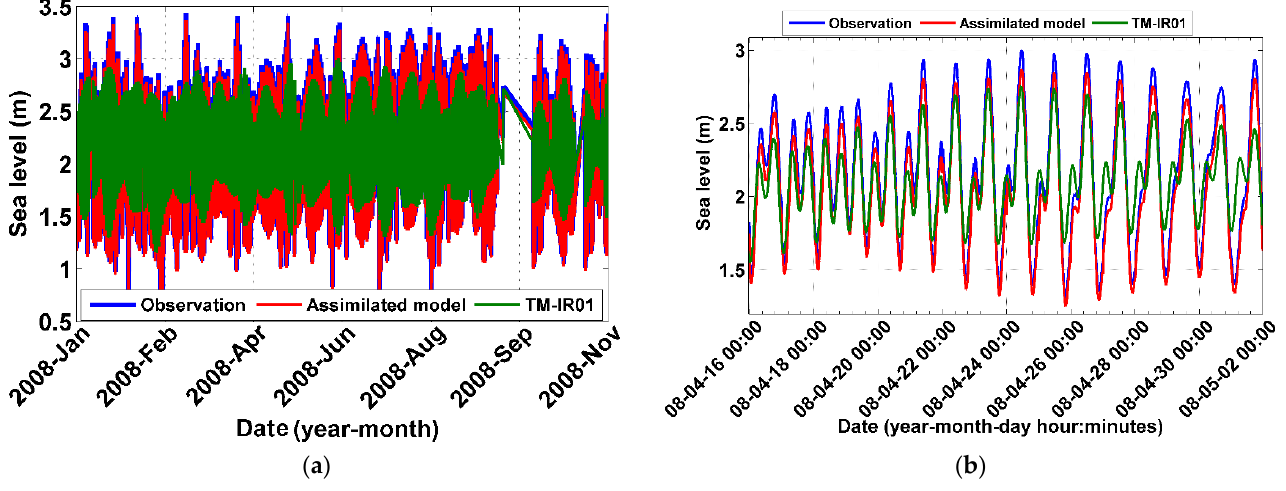
Figure 14. As a typical example, ( a ) SLH observations at Khark station (blue) and reconstructions of SLH time series with the TM ‐ IR01 model (green) and the assimilated (calibrated) model (red); ( b ) separated portion of part ( a ) to show more details.